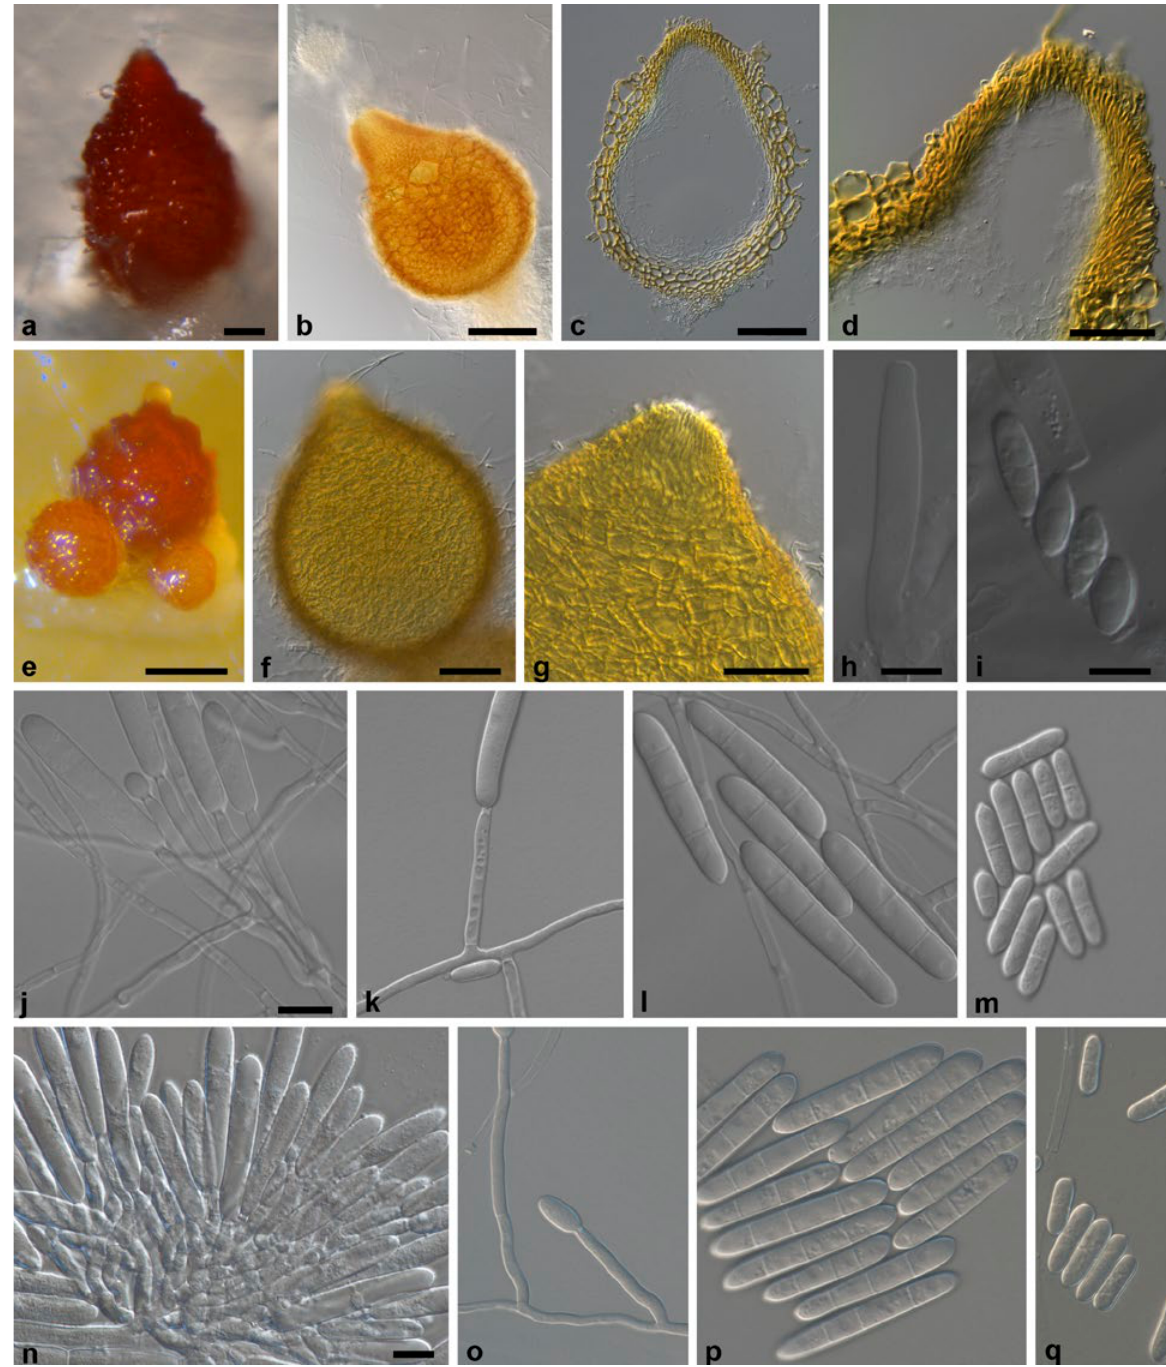
Figure 3. Dactylonectria (Adapted from Cabral et al. (2012c) Figs. 4–7). a–d, j–m. D. novozelandica . e–i, n–q. D. torresensis . a–b, e–f. Perithecial ascomata. c–d. Longitudinal sections of ascomata showing details of the papillate ostiolar region of D. novozelandica . g. Ostiolar region of D. torresensis . h. Ascus. i. Ascospores. j, n. Complex conidiophore. k, o. Simple conidi - ophores. l, p. Macroconidia. m, q. Microconidia. Bars: a–c, e = 100 μ m, d, f–g = 50 μ m, h–i = 10 μ m, j = 10 μ m (apply to k–m), n = 10 μ m (apply to